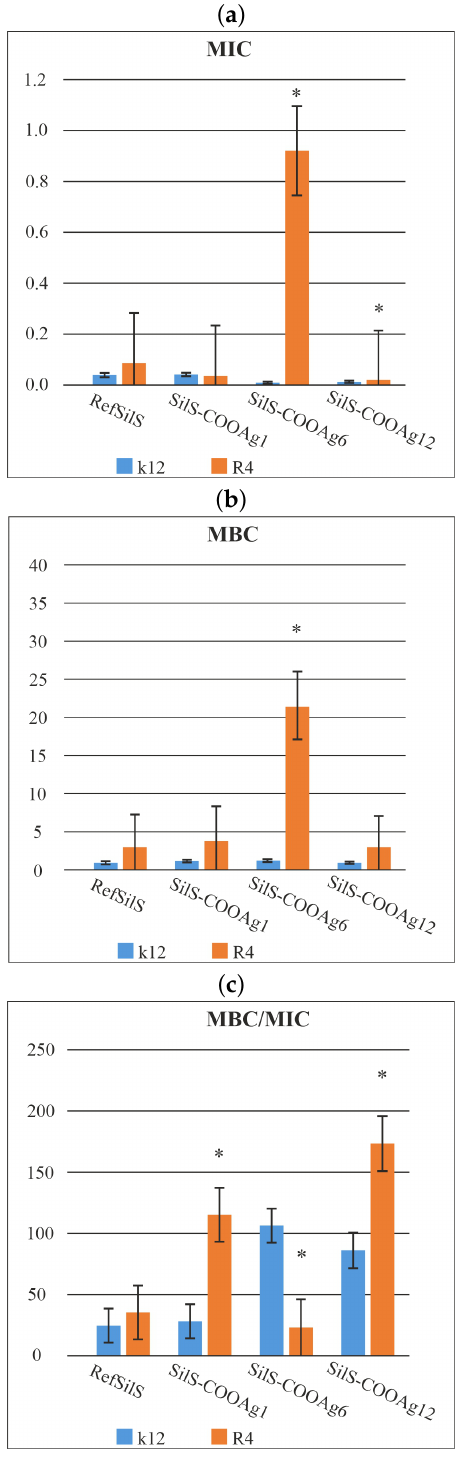
Figure 4. Minimum inhibitory concentration (MIC— a ), minimum bactericidal concentration (MBC— b ), and the ratio of MBC/MIC ( c ) of the SilS in model bacterial strains. The x-axis features compounds RefSilS, SilS-COOAg1, SilS-COOAg6, SilS-COOAg12 used sequentially. The y-axis shows the MIC value in µ g/mL − 1 . Investigated strains of E. coli K12 as control (blue), and R4 strain (orange). The sign * means statistical significance below